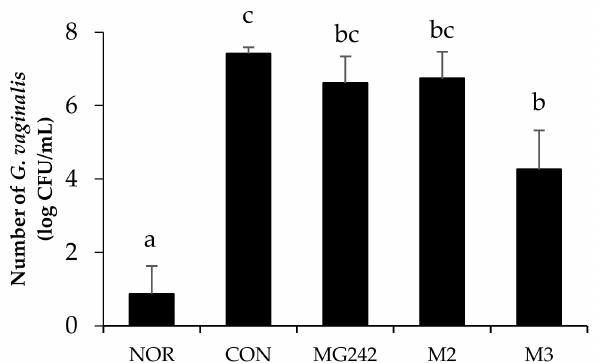
Figure 1. Antagonistic effect of the LAB against the growth of Gardnerella vaginalis . Data expressed as the mean ± standard error (SE). Statical difference among groups was analyzed using Tukey’s multiple comparison tests, and different letters (a, b, bc, and c) indicate a significant difference at p < 0.05. NOR, normal; CON, control; MG242, Lig. salivarius MG242; M2, 1:1 mixture of Lim. fermentum MG901 and Lac. plantarum MG989; M3, 1:1:1 mixture of Lig. salivarius MG242, Lim. fermentum MG901, and Lac. plantarum